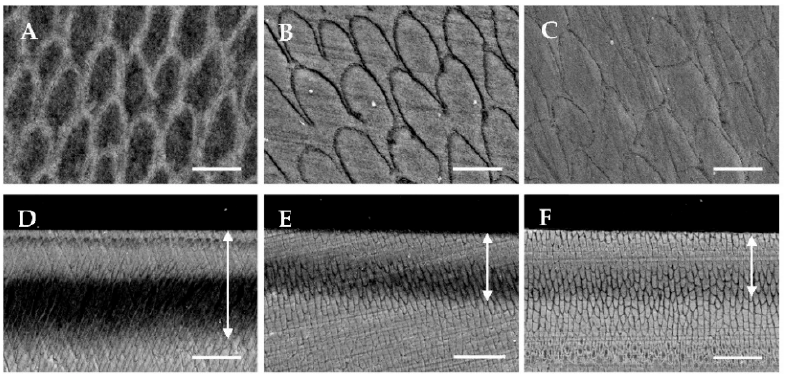
Figure 4. Scanning electron microscopy (SEM) images of enamel surface and cross-sections after acid challenge. ( A ) Surface SEM image of the control group; ( B ) APF group; and ( C ) CAP system group. (Carbon deposition sample, ( A – C ): Scale bar is 5.0 µ m); ( D ) Cross-sectional SEM image of the control group; ( E ) APF group; and ( F ) CAP system group. (Carbon deposition sample, ( D – F ): Scale bar is 25 µ m; arrows indicate demineralization depth).